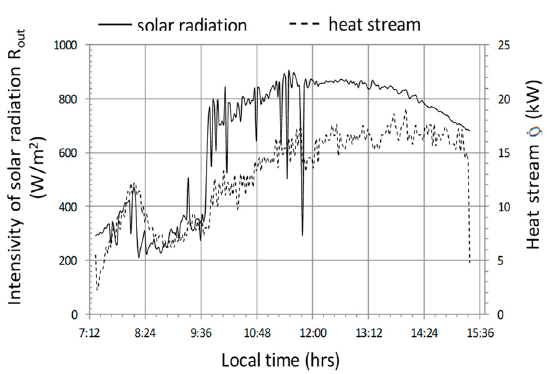
Figure 17. Timescale of solar radiation intensity and heat stream transferred to the accumulator for cycle No. 1.